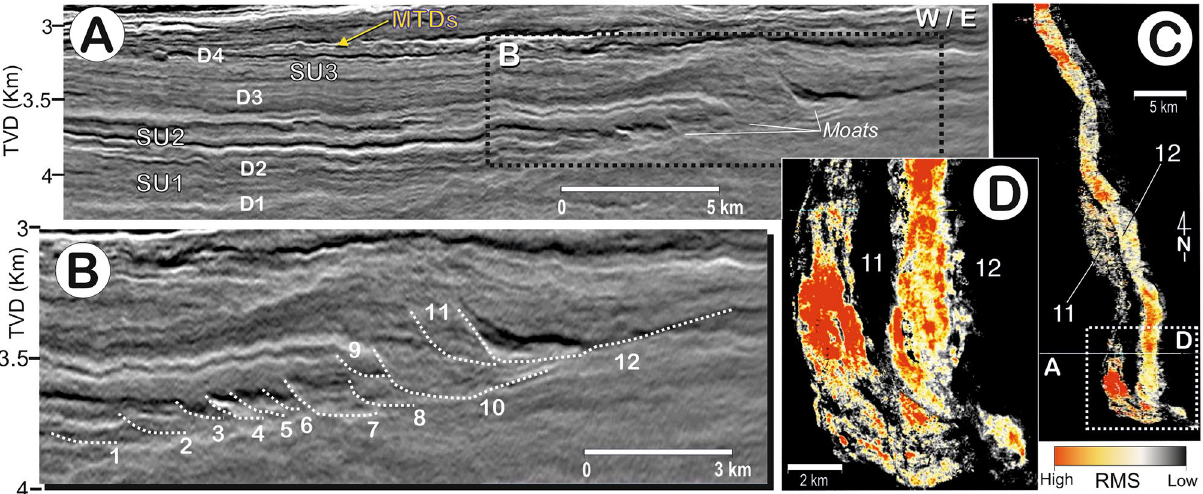
Figure 4. ( A ) 3D seismic lines indicating the seismic units, discontinuities and the position of the channels (moats). ( B ) Detail showing the lateral eastward migration of moats. ( C,D ) Root mean square (RMS) amplitude attribute extraction indicating the higher acoustic response of moats 11 and 12, especially where they